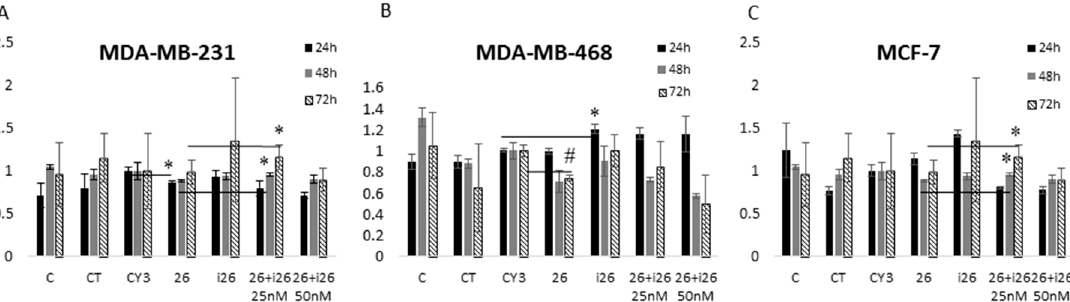
Figure 2. Determination of the miR-26a mimetic (26), the inhibitor (i26), and their combined effects on the viability of the ( A ) MDA-MB-231; ( B ) MDA-MB-468; and ( C ) MCF-7 cell lines at 24, 48, and